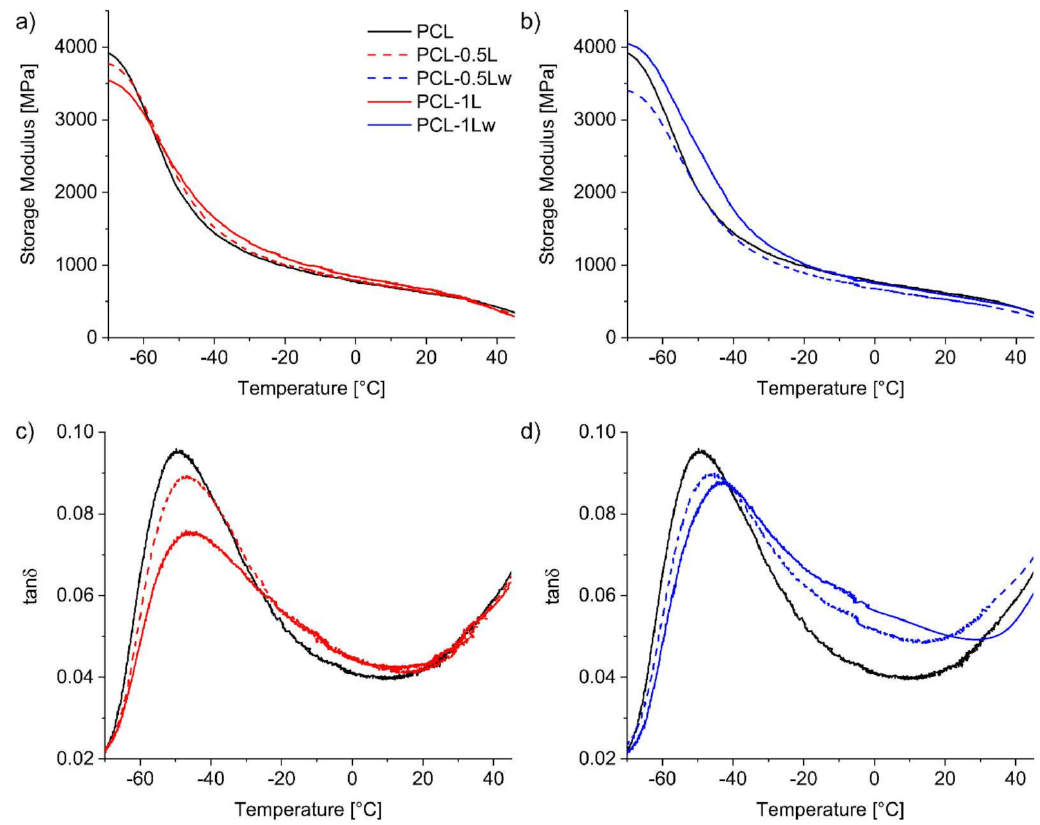
Figure 4. Representative curves of storage moduli ( a ), ( b ) and tan δ ( c ),( d ) recorded from DMTA temperature sweep of PCL and reacted PCL during dry ( a ),( c ) and water-assisted ( b ), ( d )